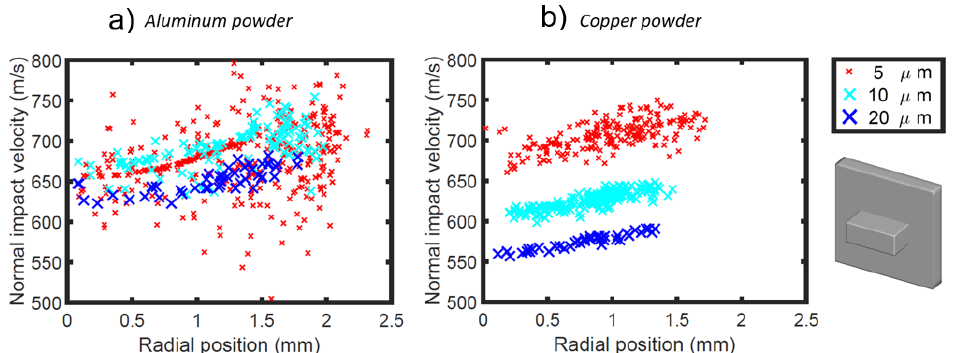
Figure 10. Normal impact velocities and radial location of ( a ) aluminum and ( b ) copper particles for the case with the vertical wall.